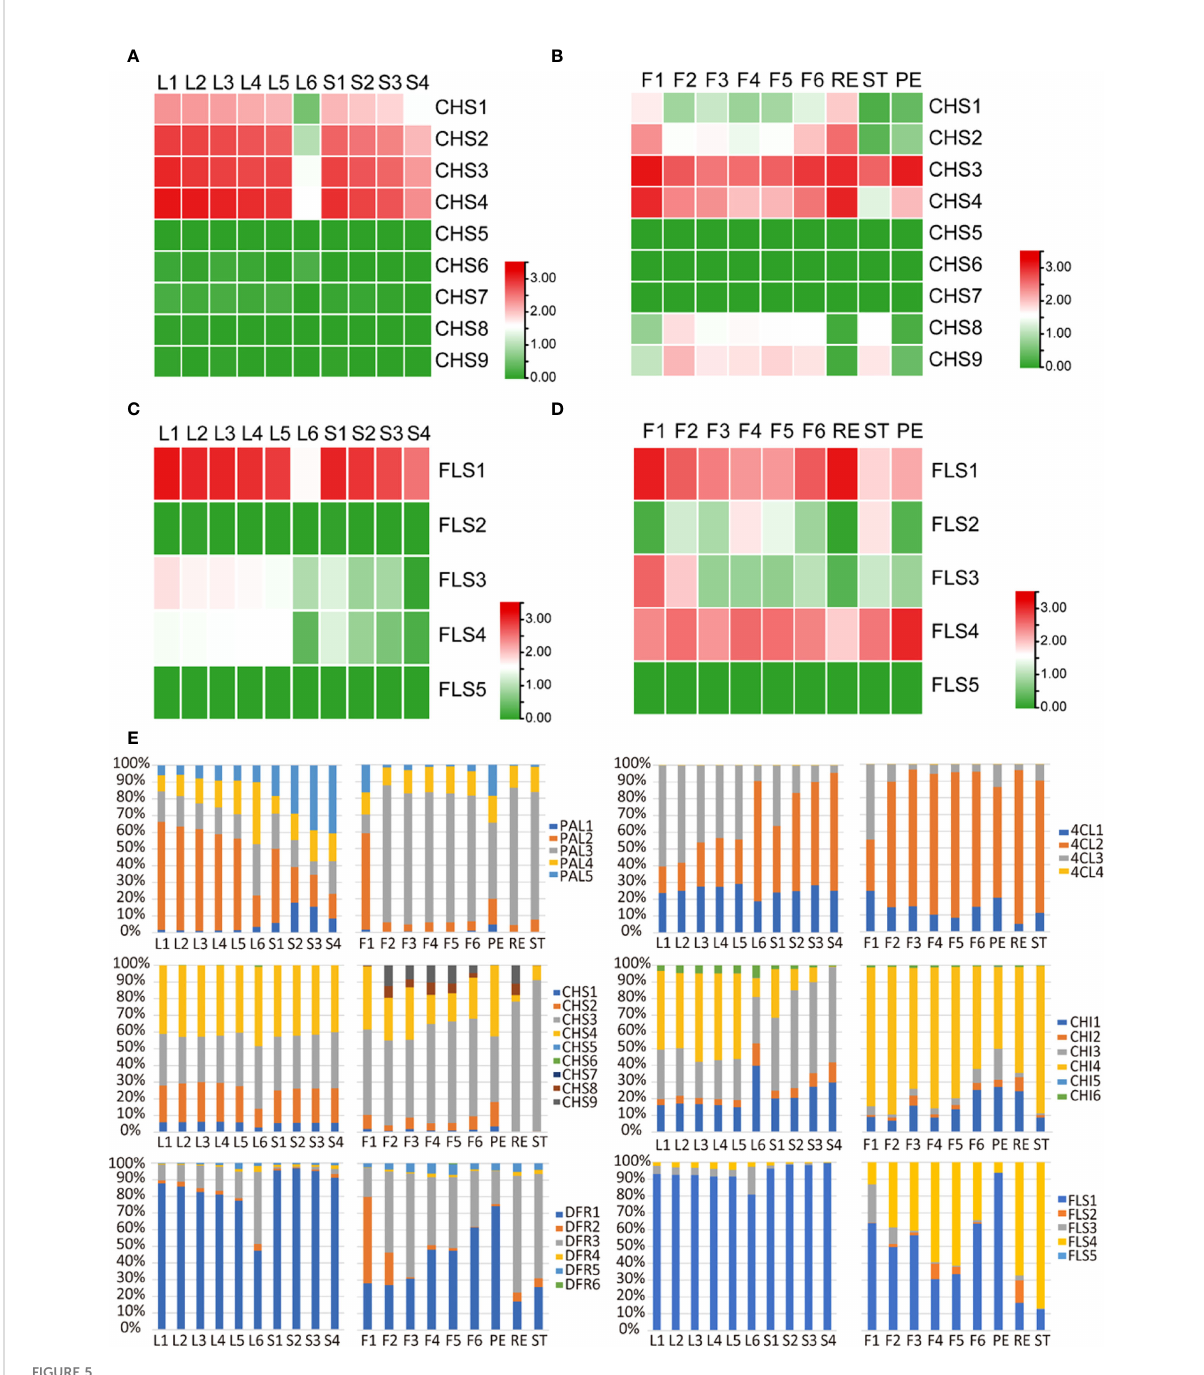
FIGURE 5 Expression analysis of gene families involved in fl avonoid biosynthesis in tea developing fl owers and leaves. (A, B) Heat map expression analysis of CHS genes in tea developing fl owers (A) and leaves (B) . (C, D) Heat map expression analysis of FLS genes in tea developing fl owers (C) and leaves (D) . (E) Relative expression level of gene family members in different tissues of tea plants. F1, tea fl ower stage 1; F2, tea fl ower stage 2; F3, tea fl ower stage 3; F4, tea fl ower stage 4; F5, tea fl ower stage 5; F6, tea fl ower stage 6; ST, stamen; PE, petal; RE, receptacle; L1, fi rst tea leaf; L2, second tea leaf; L3, third tea leaf; L4, fourth tea leaf; L5, fi fth tea leaf; L6, sixth tea leaf; S1, internode between the fi rst leaf and second leaf; S2, internode between the second leaf and third leaf; S3, internode between the third leaf and fourth leaf; S4, internode between the fourth leaf and fi fth leaf; PAL, phenylalanine ammonialyase; 4CL, 4-coumarate:CoA ligase; CHS, chalcone synthase; CHI, chalcone isomerase; DFR, dihydro fl avonol reductase; FLS, fl avonol synthase. The expression level [log10(FPKM)] of each gene is shown in the heat map